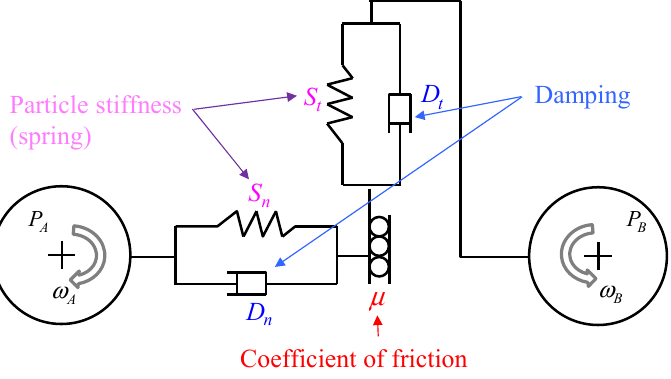
Figure 1. Illustration of contact between two particles.